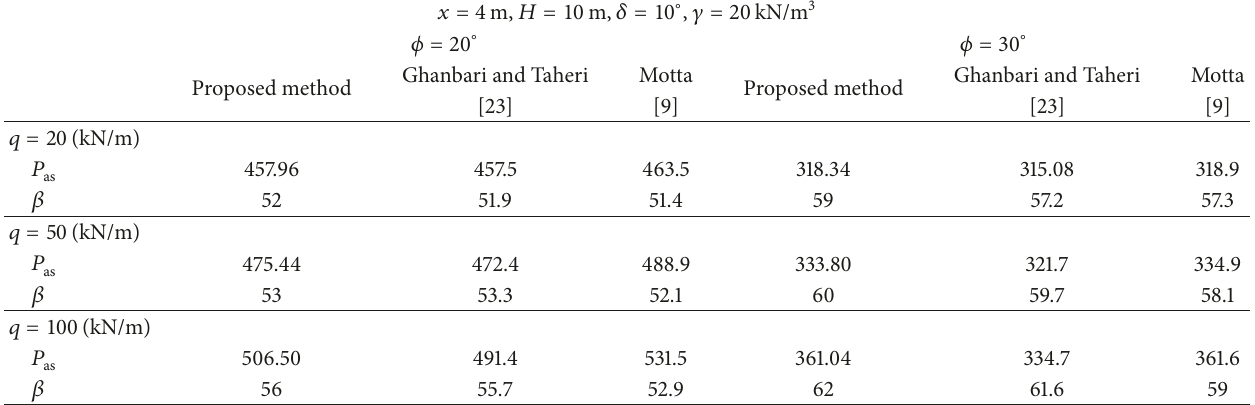
Table 2: Comparison of the results of the proposed method with Ghanbari and Taheri [23] and Motta [9].